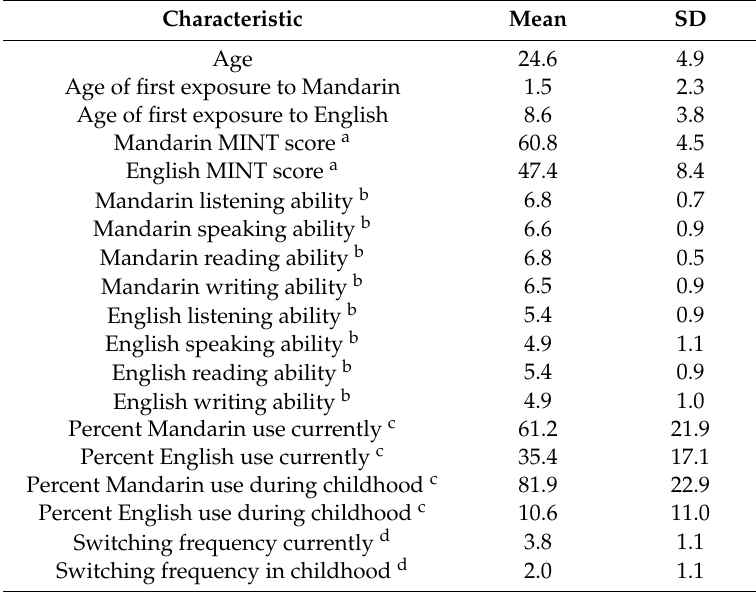
Table 3. Characteristics of included participants in Experiment